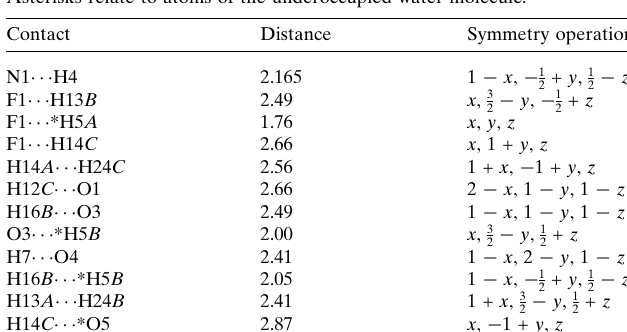
Table 2 Summary of short interatomic contacts (A˚ ) in the title compound.. Asterisks relate to atoms of the underoccupied water molecule.